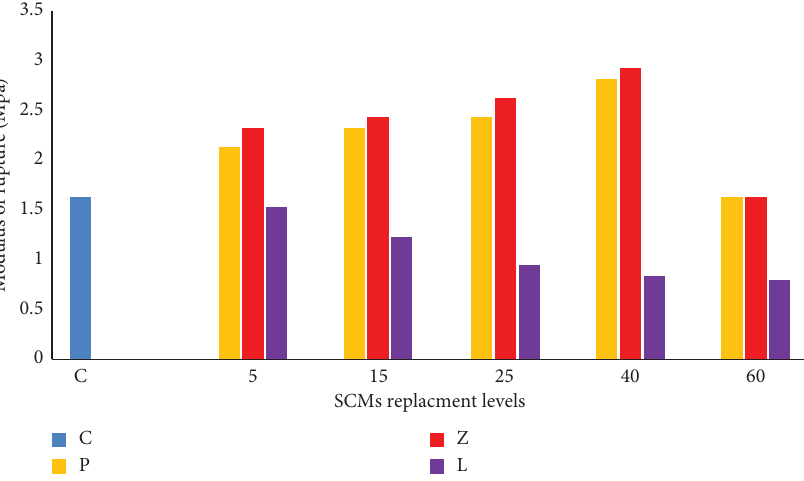
Figure 6: Modulus of rupture of the mixtures at the age of